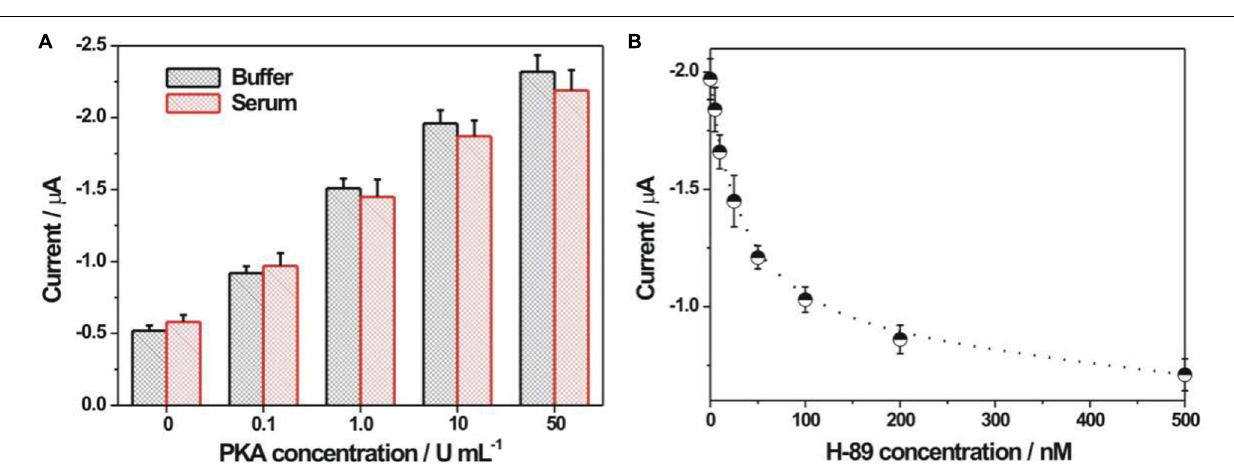
Frontiers in Bioengineering and Biotechnology |